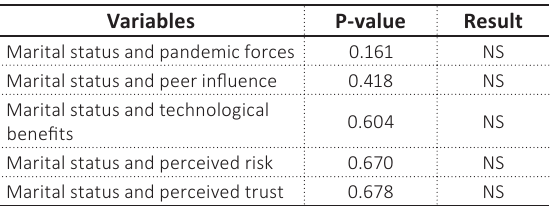
Table 4. Difference between marital status and the core variables